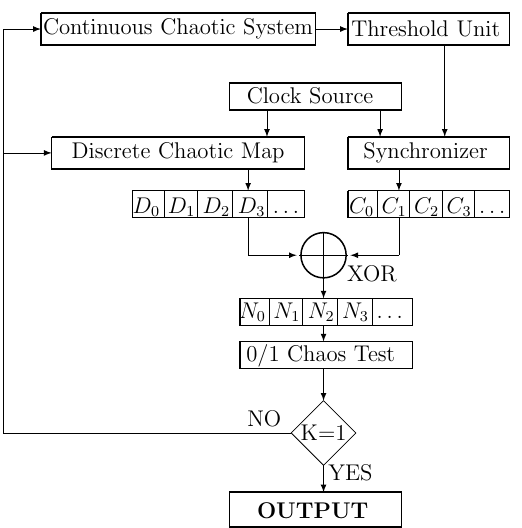
Figure 1. Schematic diagram of the XORing process of two mixed-mode signals.